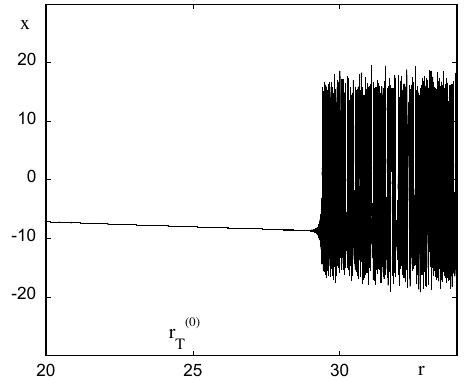
Figure 7. As in Fig. 3 but for model (13) with r 0 = 20 and threshold value | x/x ± | = 1 . 5. Other parameter values as in Fig.